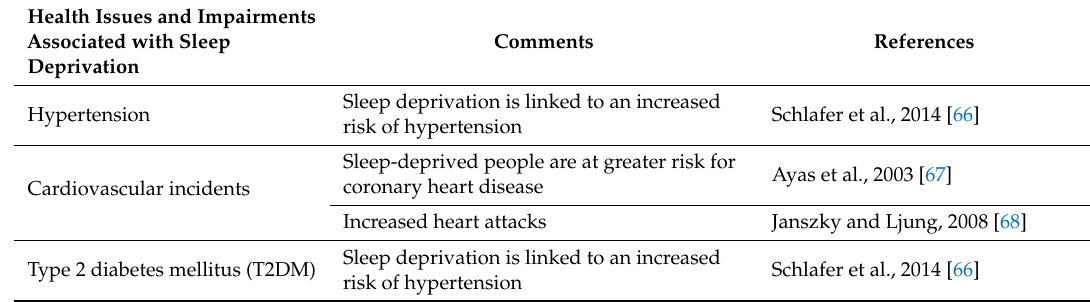
Table 1. Sleep deprivation, which has been recognized as a “public health epidemic” linked to a range of medical and mental health